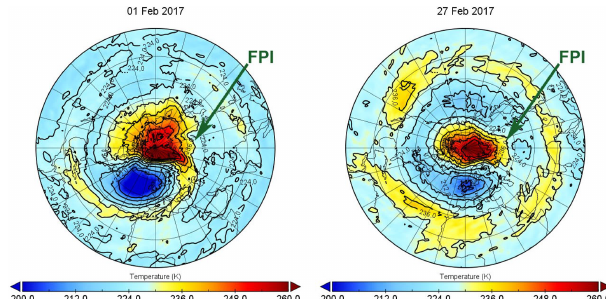
Figure 6. Same as Fig. 3 but October 2017 through March 2018.